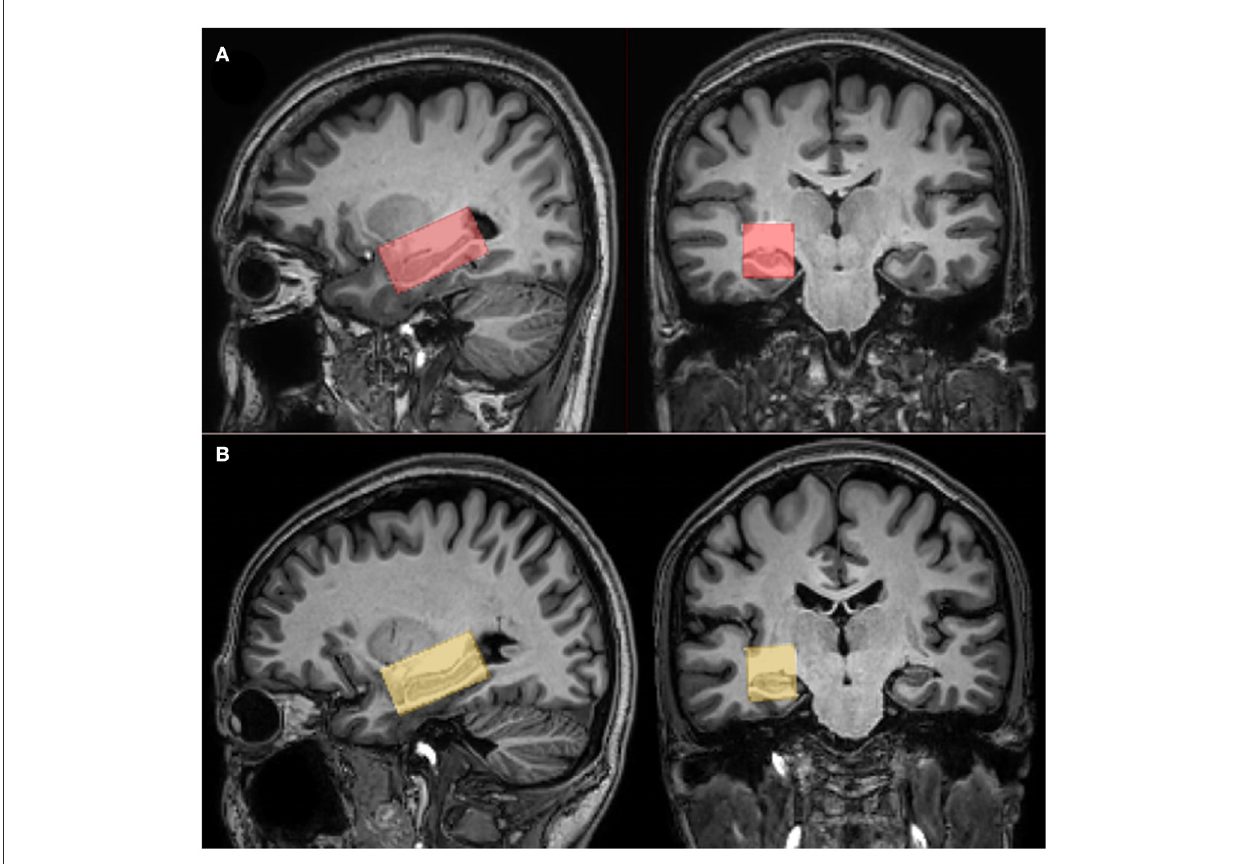
FIGURE1 The position of voxels and segmentation data. Coronal and sagittal T1-weighted TFE images show single-voxel placements centered on the right hippocampus in a healthy participant [female, 64 years (A) ] and a patient with amnestic mild cognitive impairment (aMCI) [women, 66 years (B) ].